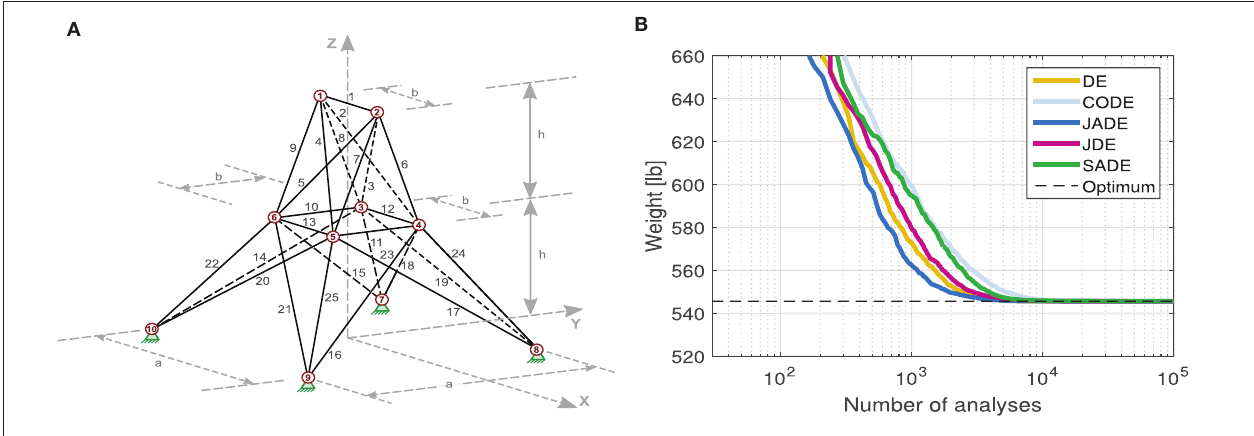
FIGURE 1 | 25-bar space truss (A) geometry; (B) algorithms’ convergence histories (average of 30 runs).